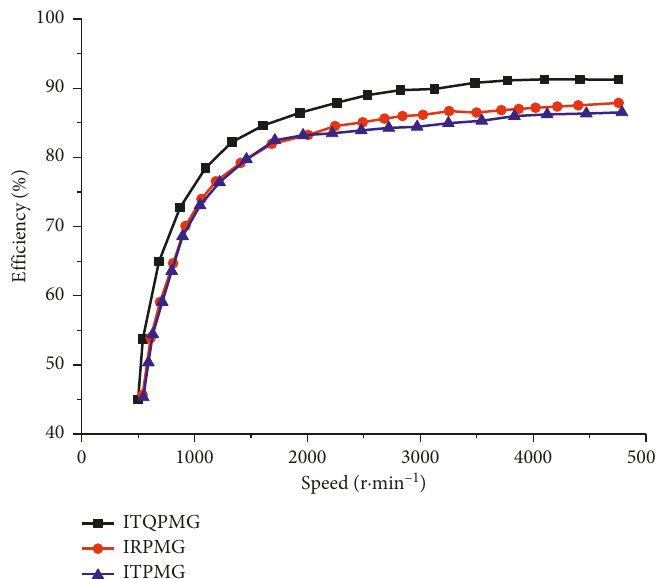
Figure 11: Efficiency curves of three permanent magnet generators.